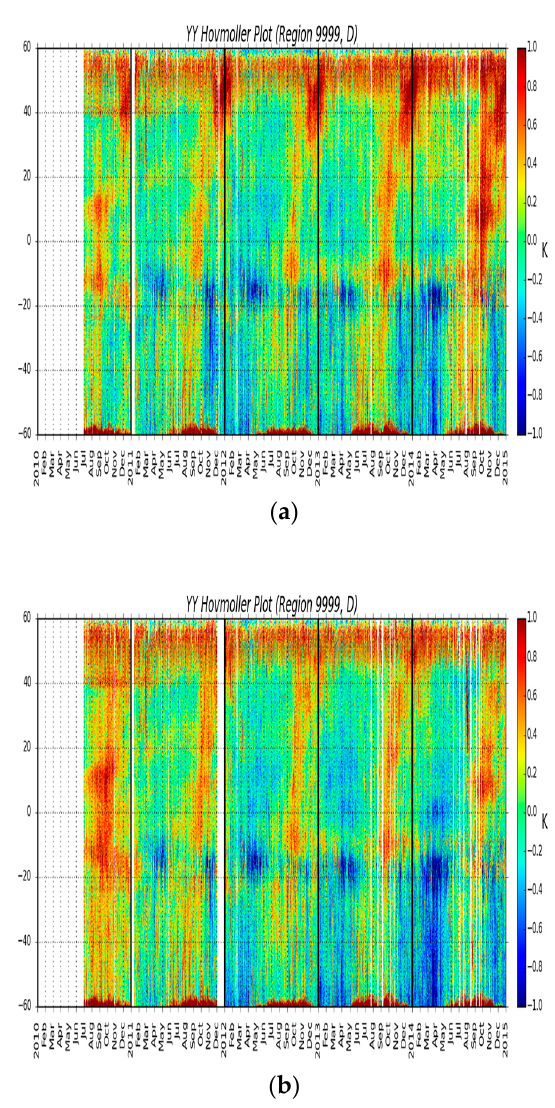
Figure 9. Hovmoller plot showing Y pol BT bias over the ocean as a function of time and latitude with ( a ) and without ( b ) the Tp7 correction.